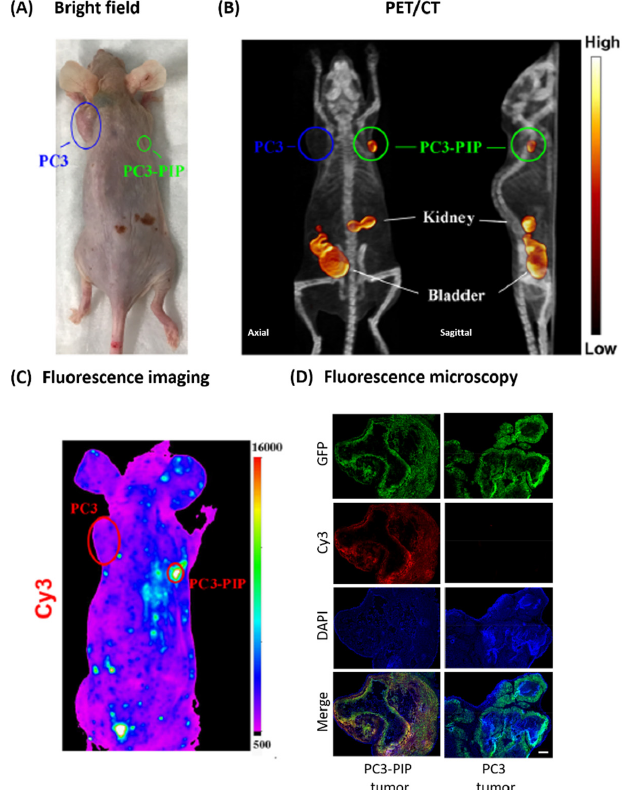
Figure 2. Selective PET and fluorescence imaging of PSMA-expressing (PC3-PIP) tumors compared to non-PSMA-expressing tumors (PC3) on a xenografted mouse model with PSMA-targeting probe [ 18 F] 12 . ( A ) Bright-field image. ( B ) PET / CT imaging 6 h post-injection. ( C ) Whole-body fluorescence imaging of compound 12 showing selective accumulation in PSMA-expressing tumor. ( D ) Fluorescence microscopy of tumor sections. Compound 12 was selectively accumulated in PC3-PIP tumors (left column) as opposed to PC3 tumors (right column). Scale bar is 250 µ m. Adapted with permission from [100]. Copyright 2019 American Chemical